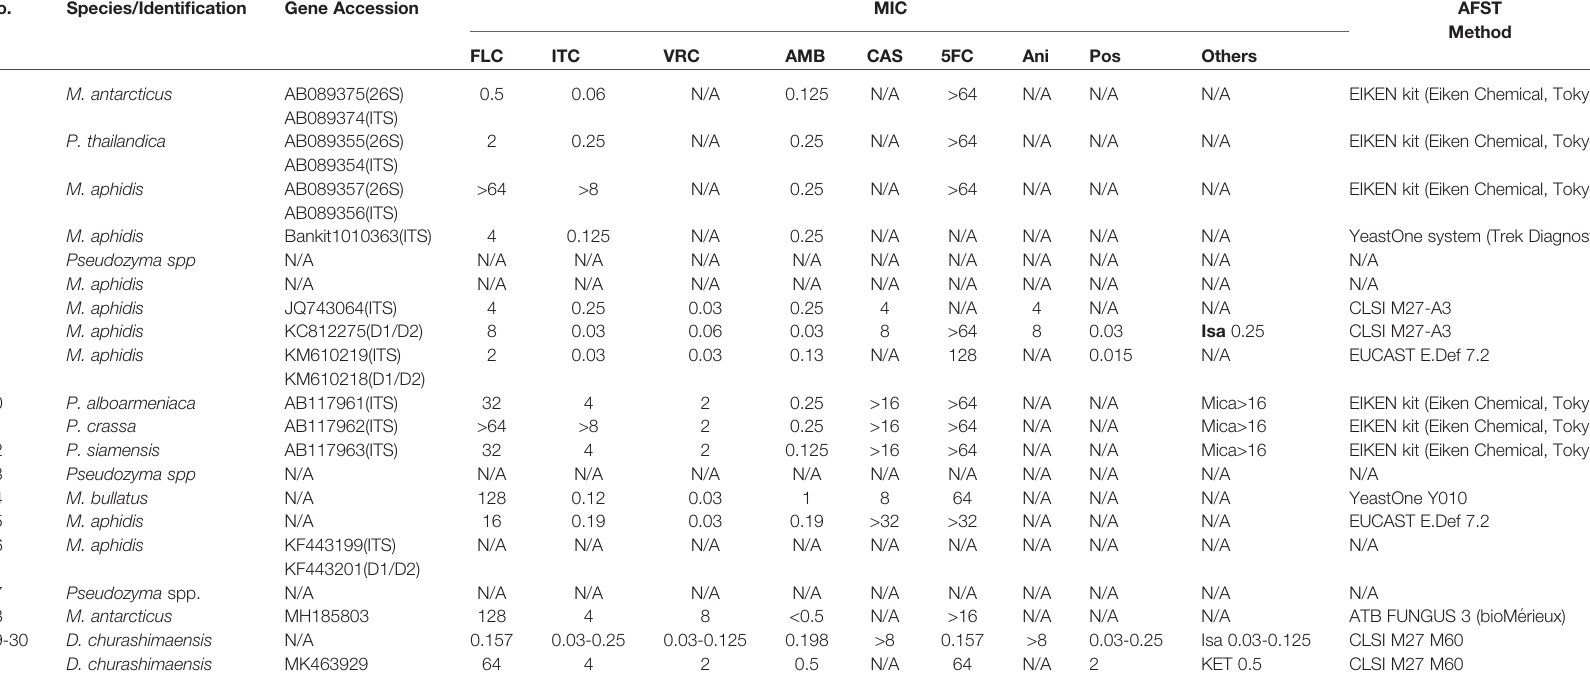
TABLE 2 | Strain information of Ustilaginales infections in